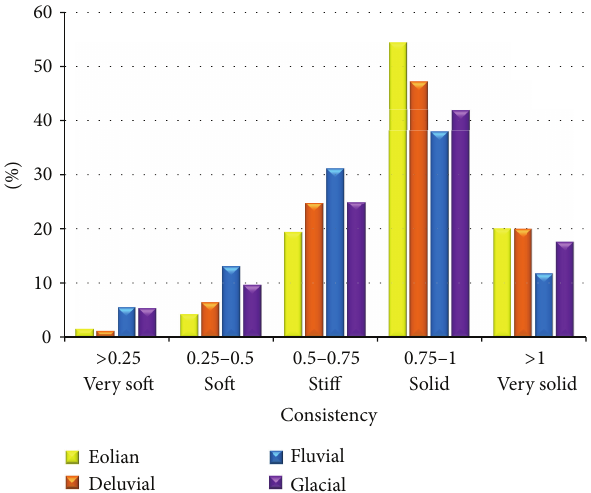
Figure 5: Percentages of the consistency degrees in the individual genetic